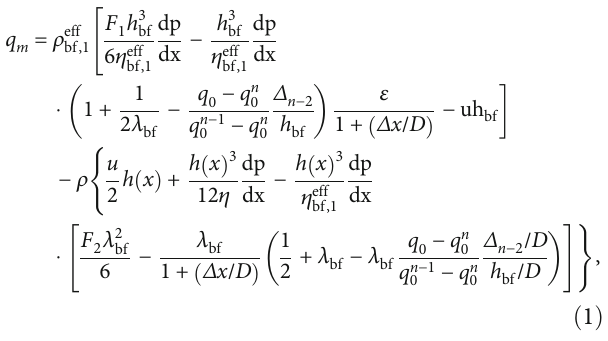
h h ; h is the thickness of the adsorbed boundary where λ = / bf bf bf layer; h is the intermediate continuum fl uid fi lm thickness; ρ is the hydrodynamic pressure; x is the coordinate shown in Figure 1; u is the sliding speed and here is positive; ρ and η are, respectively, the bulk density and the bulk viscosity of the fl uid; ρ eff and η eff are, respectively, the average density bf , 1 bf , 1